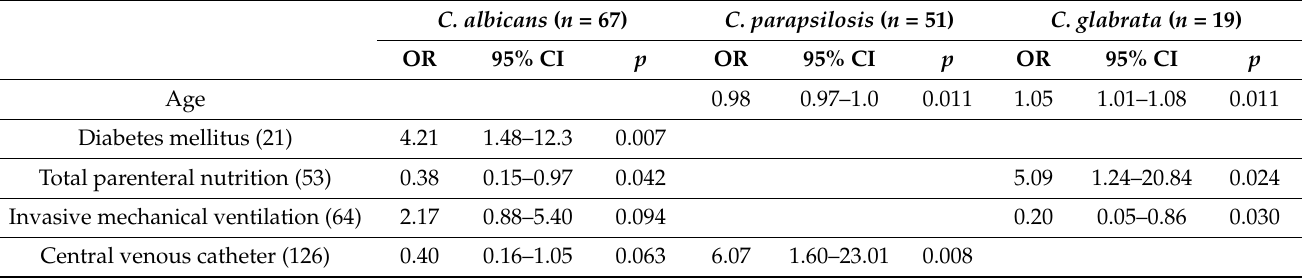
Table 4. Independent risk factors associated with the three most frequently isolated Candida spp. ( n =